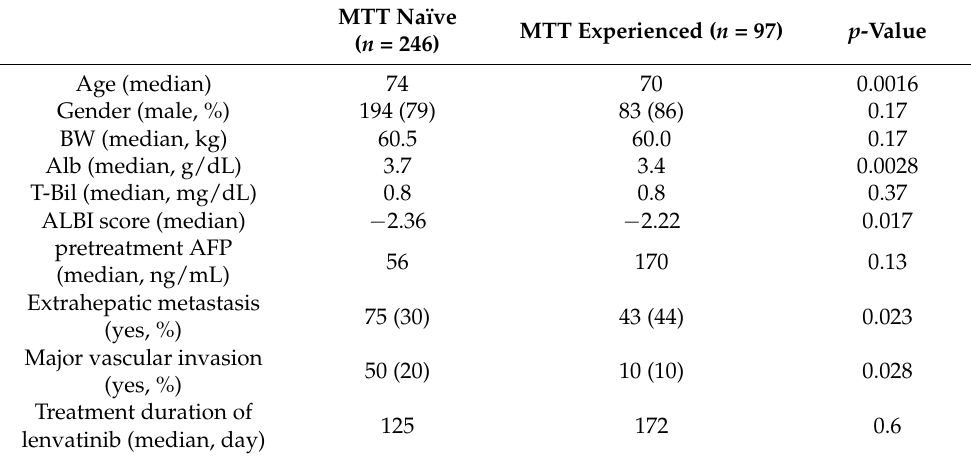
Table 2. Comparison of the baseline characteristics between MTT naïve and experienced patients.